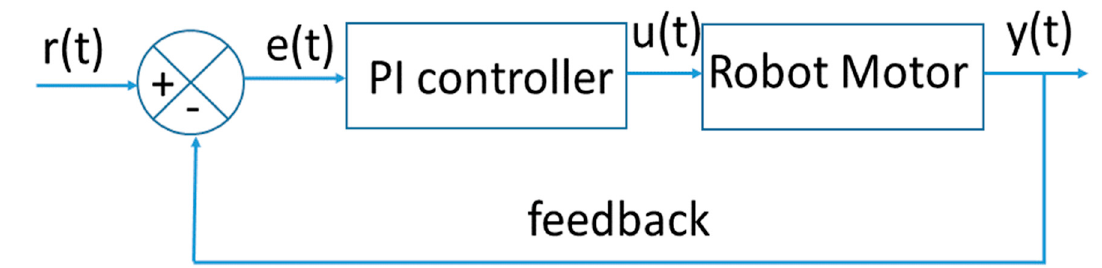
Figure 5. General structure for the PI controller.